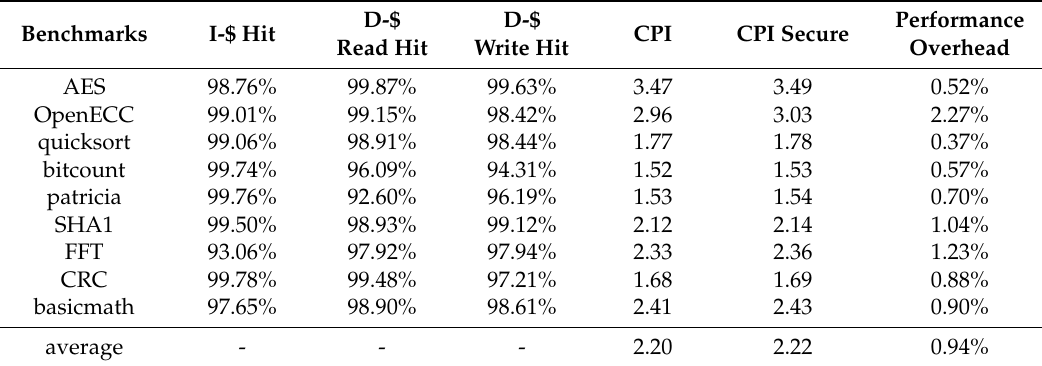
Table 2. The performance overhead of the selected benchmarks with 4 KB I-$ and 1 KB D-$.